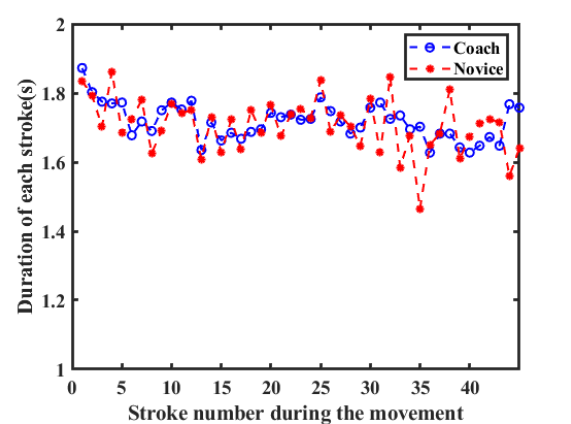
Figure 13. The duration of each stroke versus the stroke numbes during the rowing